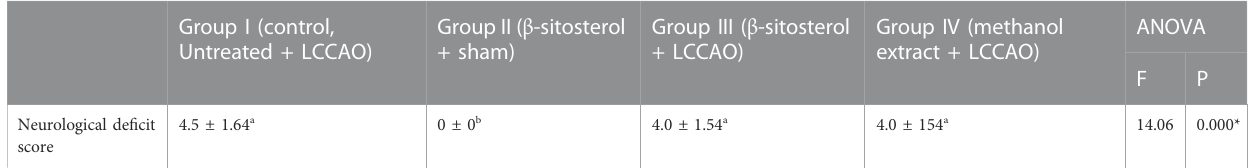
TABLE 2 Neurological de fi cit score of experimental